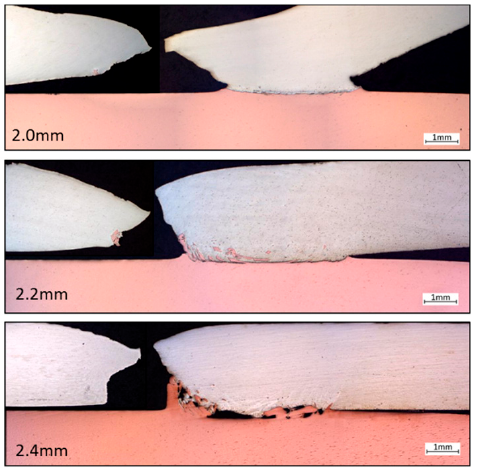
Figure 7. Influence of the pin length on the failure behaviour.